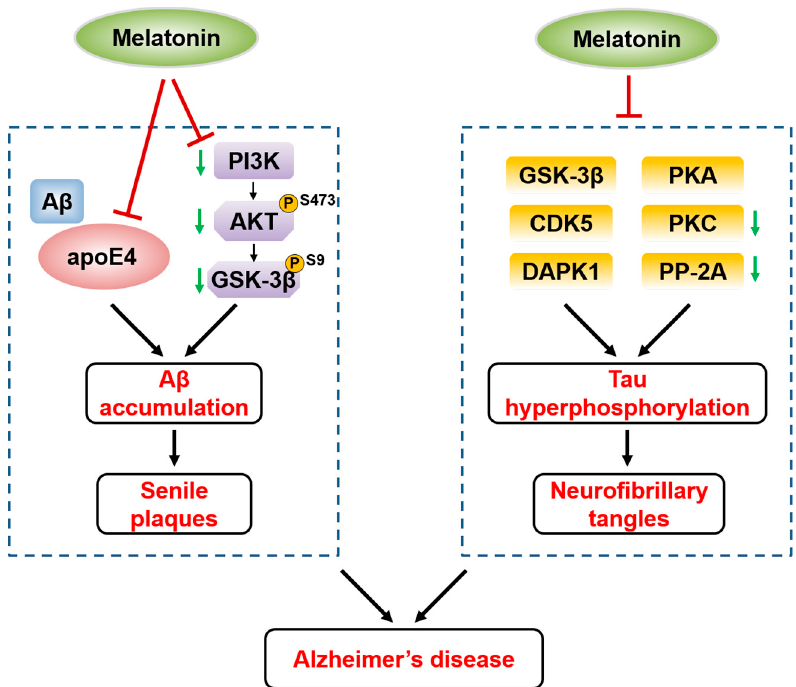
Figure 2. The regulation of A β and tau through different kinases in Alzheimer’s disease (AD), which is attenuated by melatonin. Melatonin directly binds to and inhibits apoE4, which enhances A β toxicity via combination with A β , thereby reducing A β pathology in AD. Moreover, melatonin suppresses the reduction of PI3K activity, pSer473 on Akt and pSer9 on GSK-3 β , leading to the reduction of A β aggregation in AD. Melatonin attenuates tau pathology by regulating several kinases such as GSK-3 β , CDK5, PKC, PKA and DAPK1, and the protein phosphatase PP-2A in AD. ↓ , reduction.